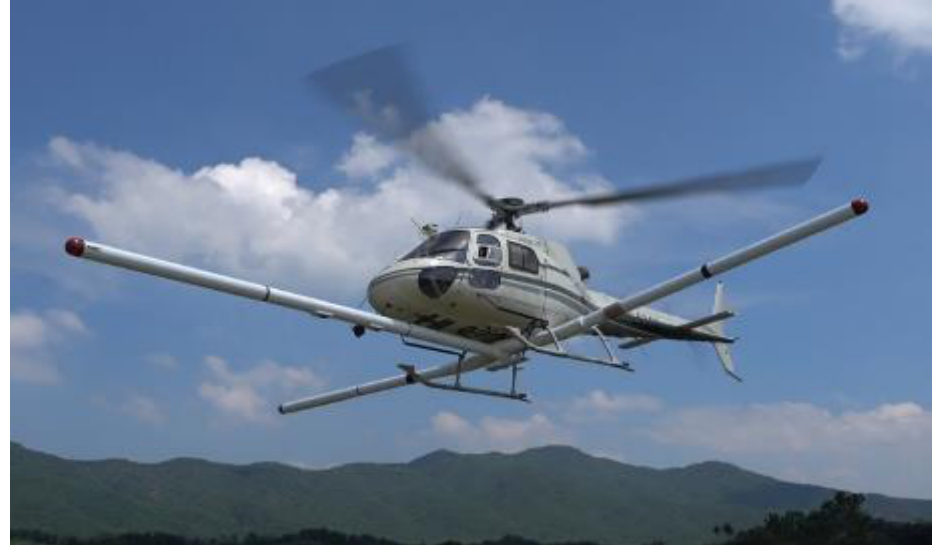
Figure 2. Manned aeromagnetic survey system used by the Korean Institute of Geoscience and Mineral Resources (KIGAM).